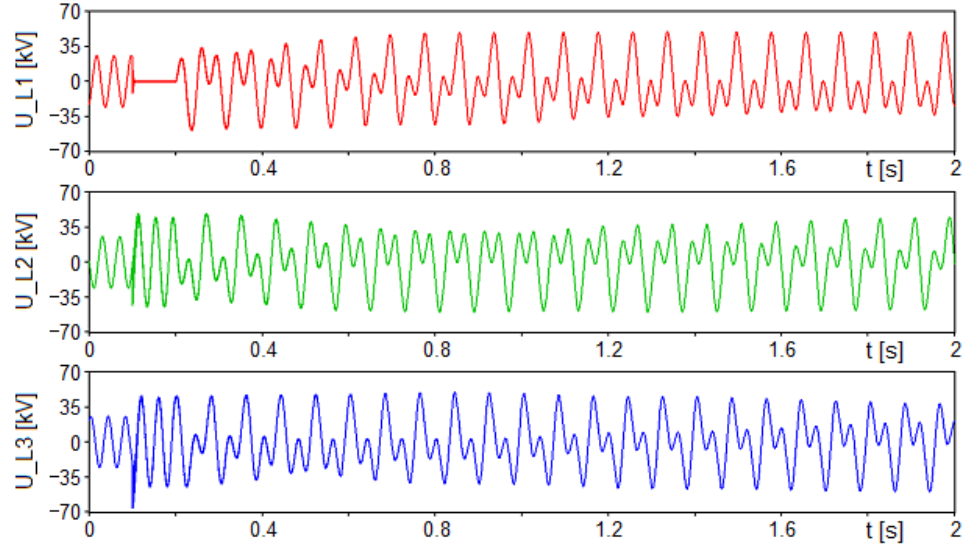
Figure 5. Waveforms of phase voltages on the primary side of voltage transformers under ferroresonant oscillation conditions.